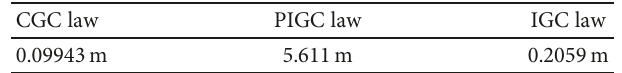
Table 1: Miss distance under the three control laws against a fi xed target.